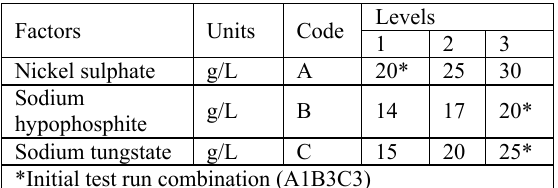
Table 1. Factors varied in the coating bath